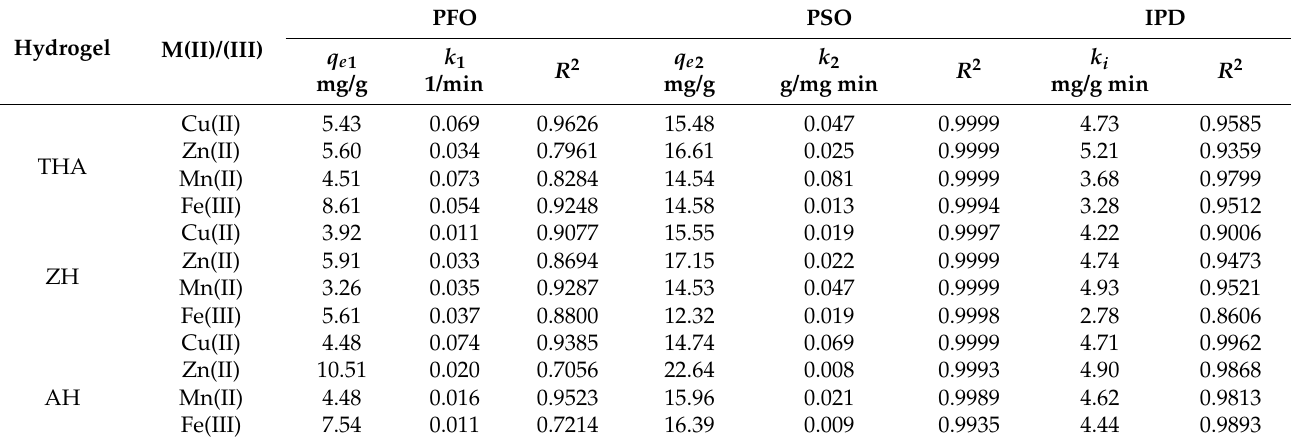
Table 2. The kinetic parameters for the sorption of Cu(II), Zn(II), Mn(II) and Fe(III) complexes with EDDS on AH, ZH and THA.